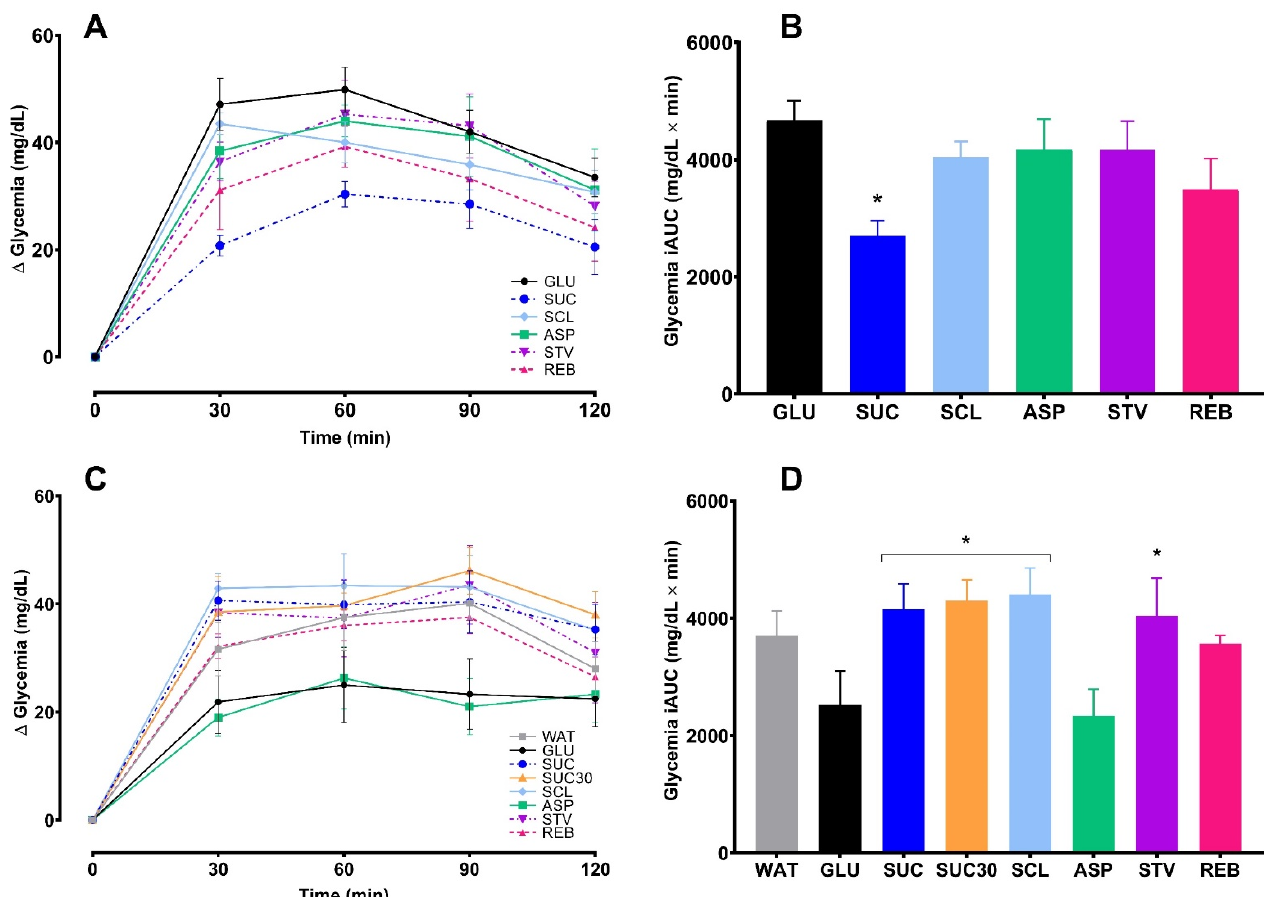
Figure 6. Effects of NNS on glycemic response expressed as change from baseline ( ∆ glycemia) and incremental area under curves (iAUC), during an oral starch tolerance test (OSTT) over 120 min performed after 12 h of fasting at the end of interventions in ND ( A , B ) and HFD-treated group ( C , D ). Data are expressed as mean ± SEM. ( n = 6–8 per group). One-way ANOVA and Dunnett’s post hoc test showed a reduced glycemia iAUC in SUC respect to GLU in the ND group (* p < 0.05) and in HFD, an increased glycemia iAUC in SCL, STV, SUC and SUC30 compared to GLU (* p < 0.05). WAT, water; GLU, glucose; SUC, sucrose; SUC30, 30% sucrose; SCL, sucralose; ASP, aspartame; STV, stevia; REB, reb A.